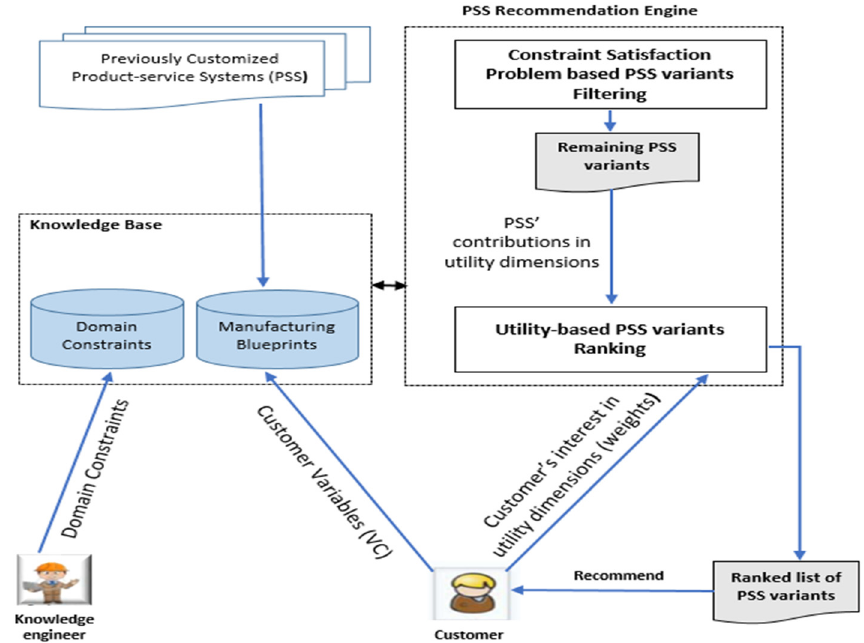
Figure 2. An overview of the proposed recommendation approach.